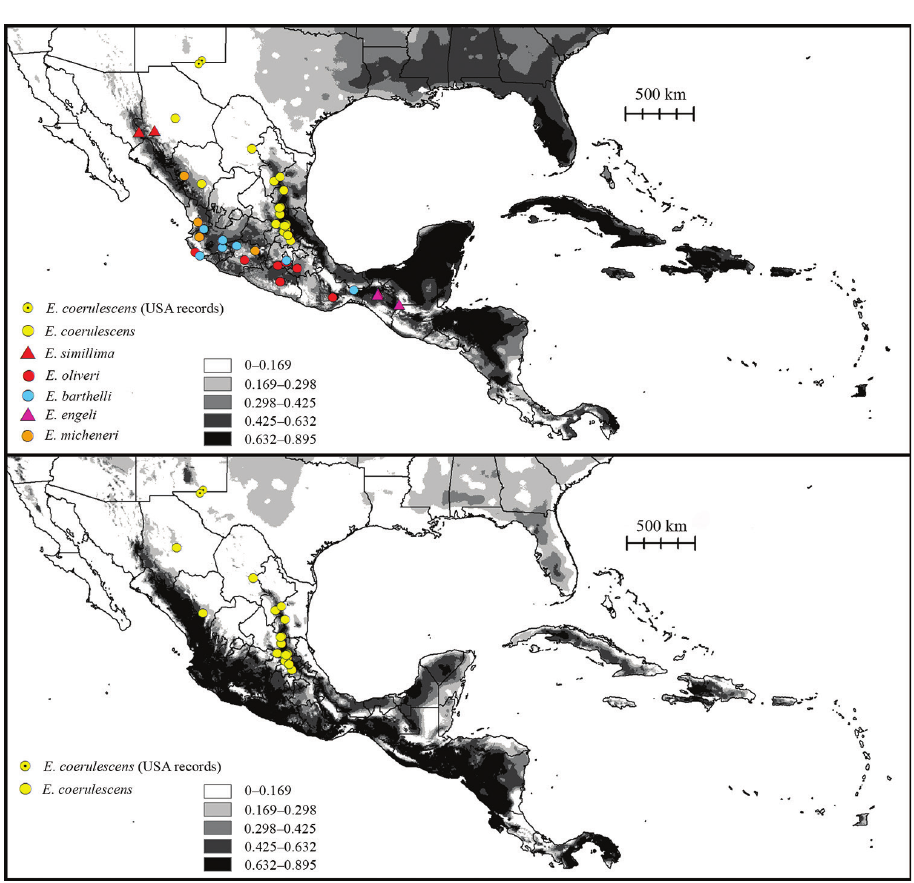
Figure 129. Potential distribution for all species of Eufriesea of the coerulescens group combined (top map) and for E. coerulescens alone (bottom map) with collection